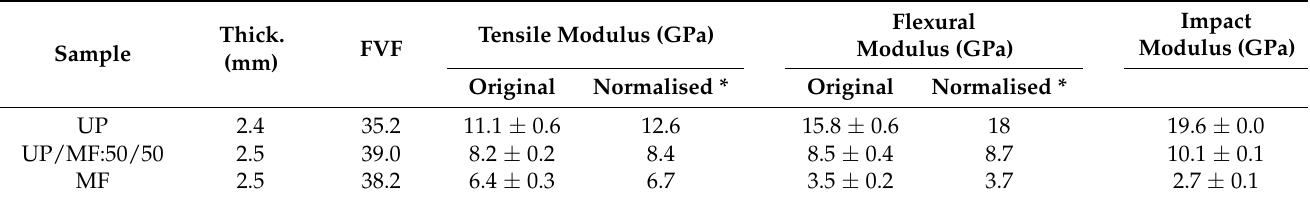
Table 8. Mechanical properties of GFRCs of UP, MF, and their 50/50